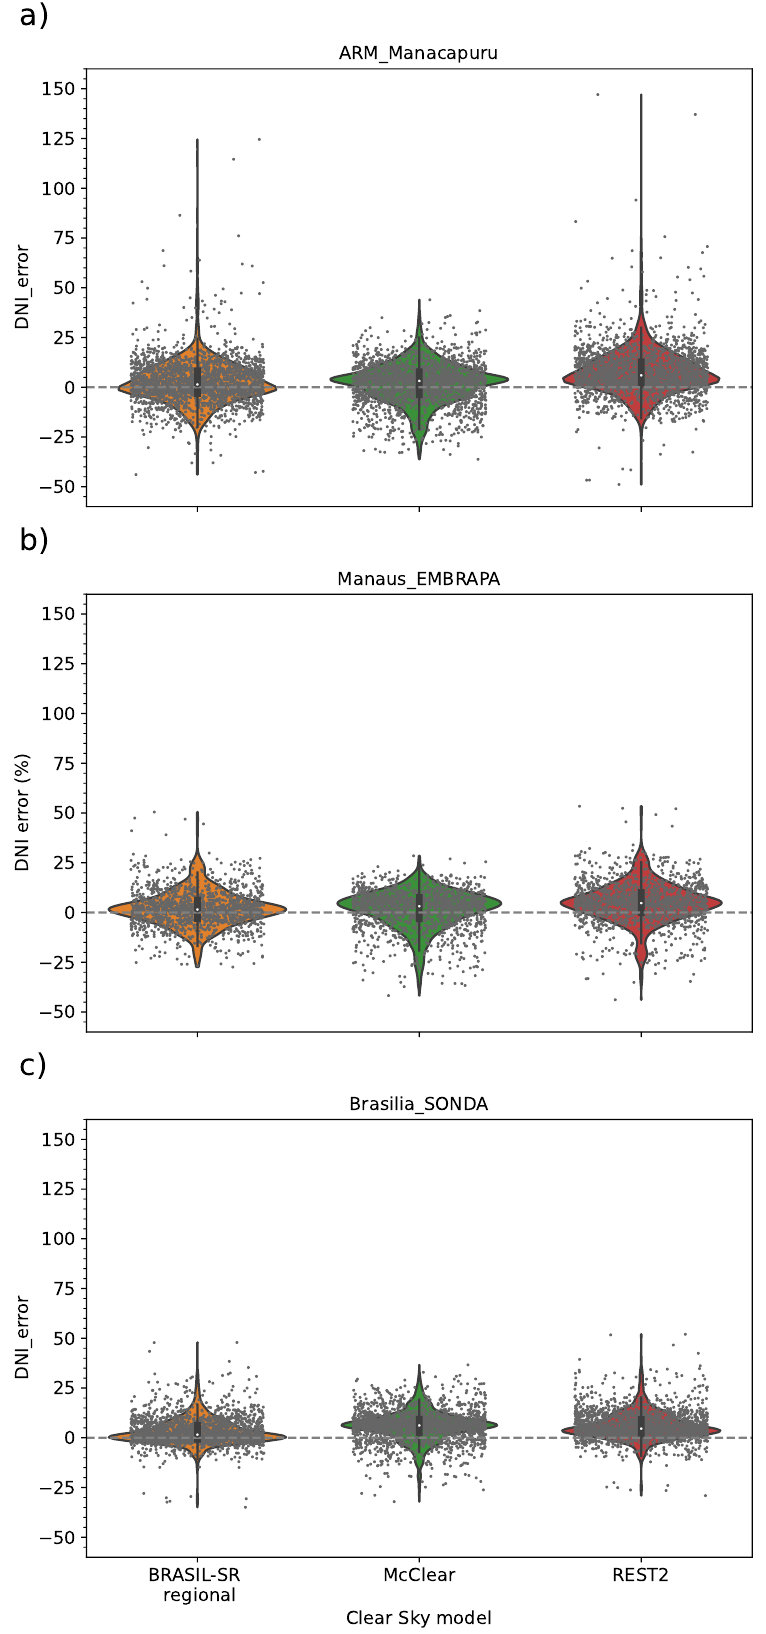
Figure 12. Combined violin and strip plots of the deviations of the BRASIL-SR regionalexperiment DNI without δ -Eddington scaling, McClear and REST2 for ARM_Manacapuru ( a ), Manaus_EMBRAPA ( b ) and Brasilia_SONDA ( c